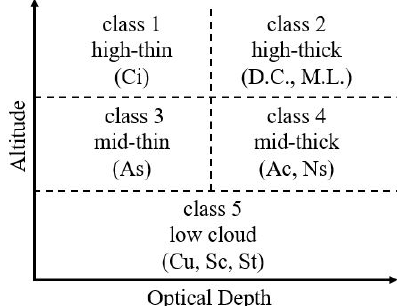
Figure 5. Cloud types in CloudSat 2B-CLDCLASS-lidar product